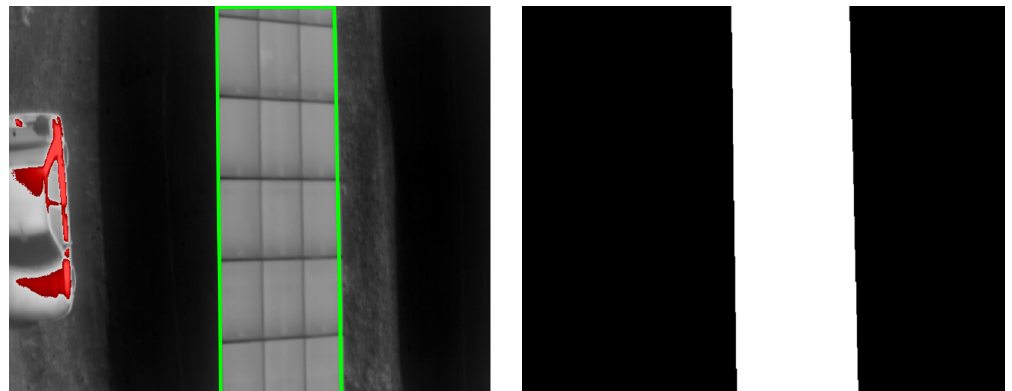
Figure 10. Panels surface detection. The image on the left shows the boundary of the detected panel and the image on the right shows the binary mask, where the white area shows the surface of the panel.